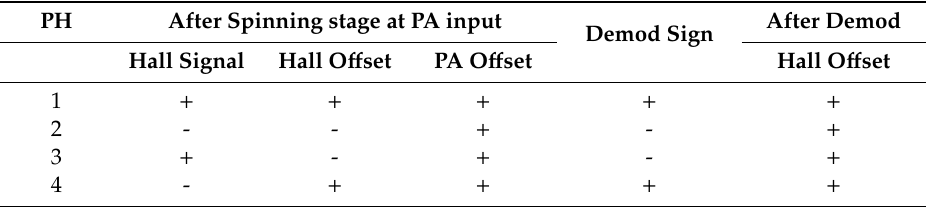
Table 3. Demodulation key applied on the amplified spinning output for the extraction of the Hall o ff set.